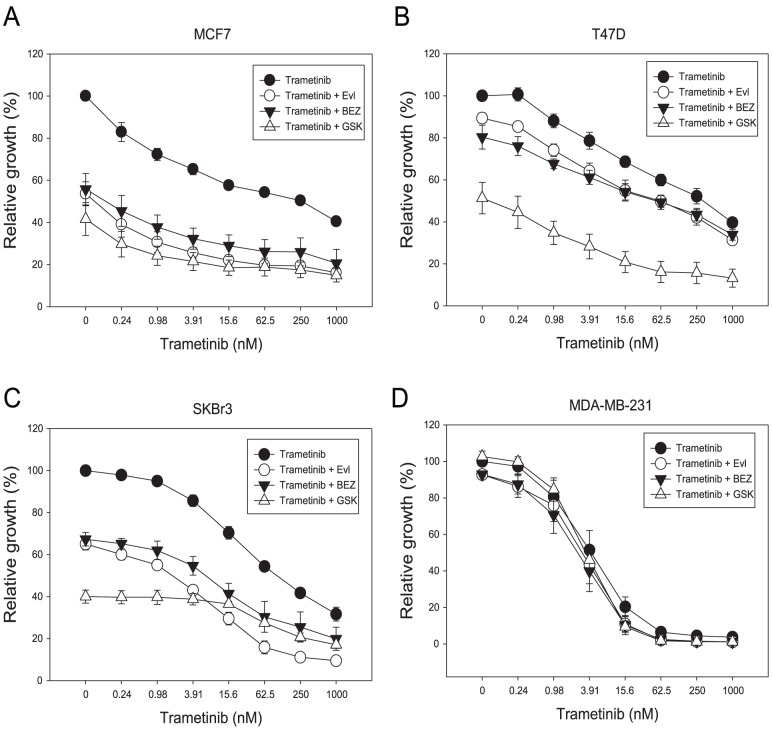
Growth inhibitory effects of combined drug treatments in MCF-7, T47D, SKBr3 and MDA-MB-231 cell lines.Cells were treated with trametinib in association with everolimus, NVP-BEZ235 or GSK2126458 for 3 days with [3H]-thymidine added for the last 6 hours. Results were shown as the mean ± standard error from duplicate experiments.